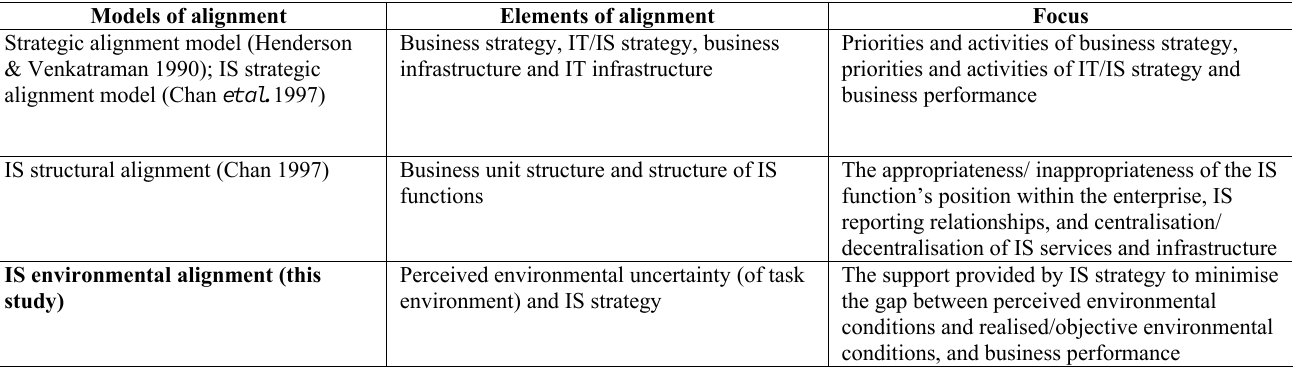
Table 2: Models of alignment Models of alignment Elements of alignment Strategic alignment model